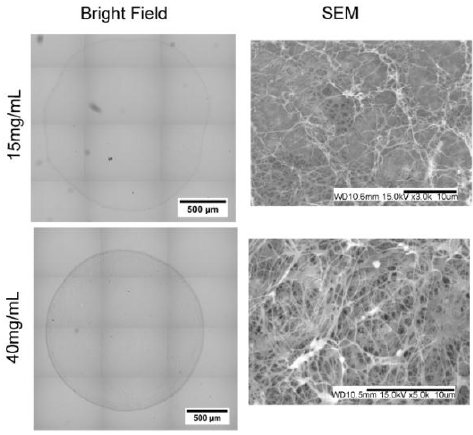
Figure 4. Bead Cross-Section and